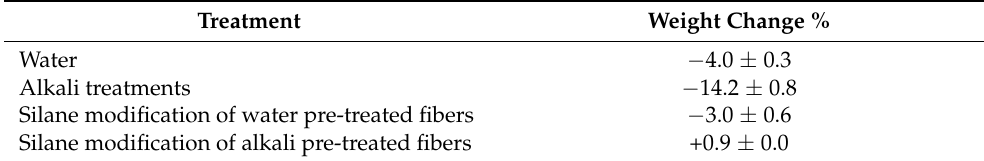
Table 2. The mass change of the hemp fiber following